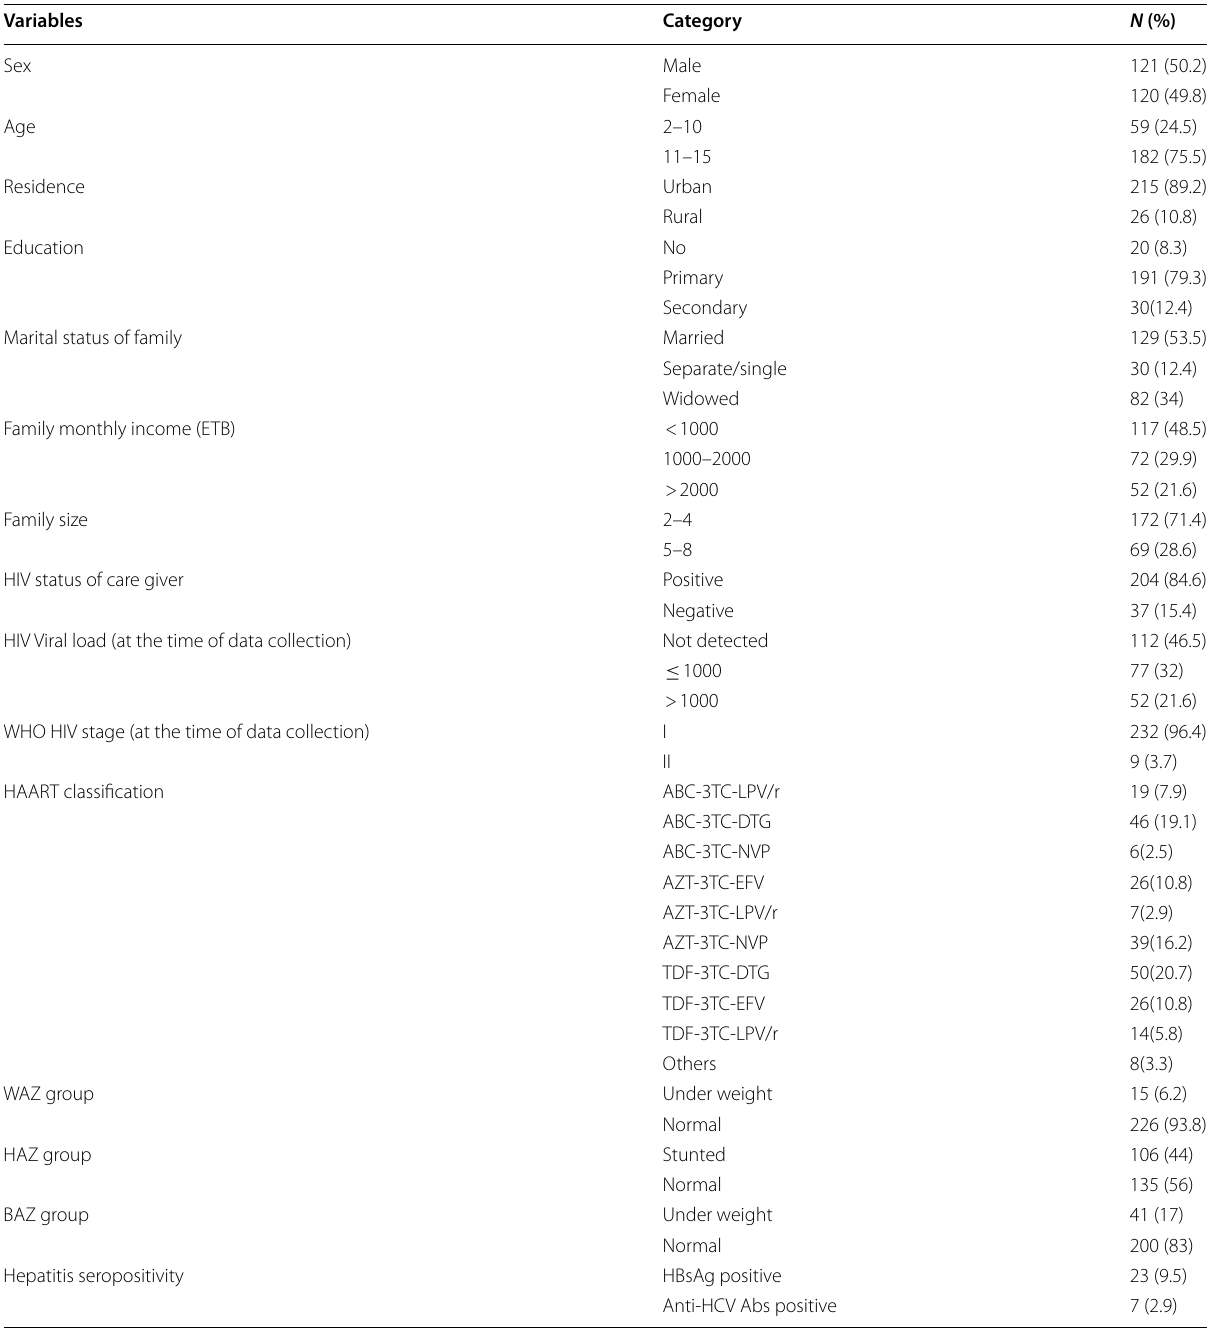
Table 1 Socio-demographic and clinical characteristics of HAART experienced children at the UoGCSH,